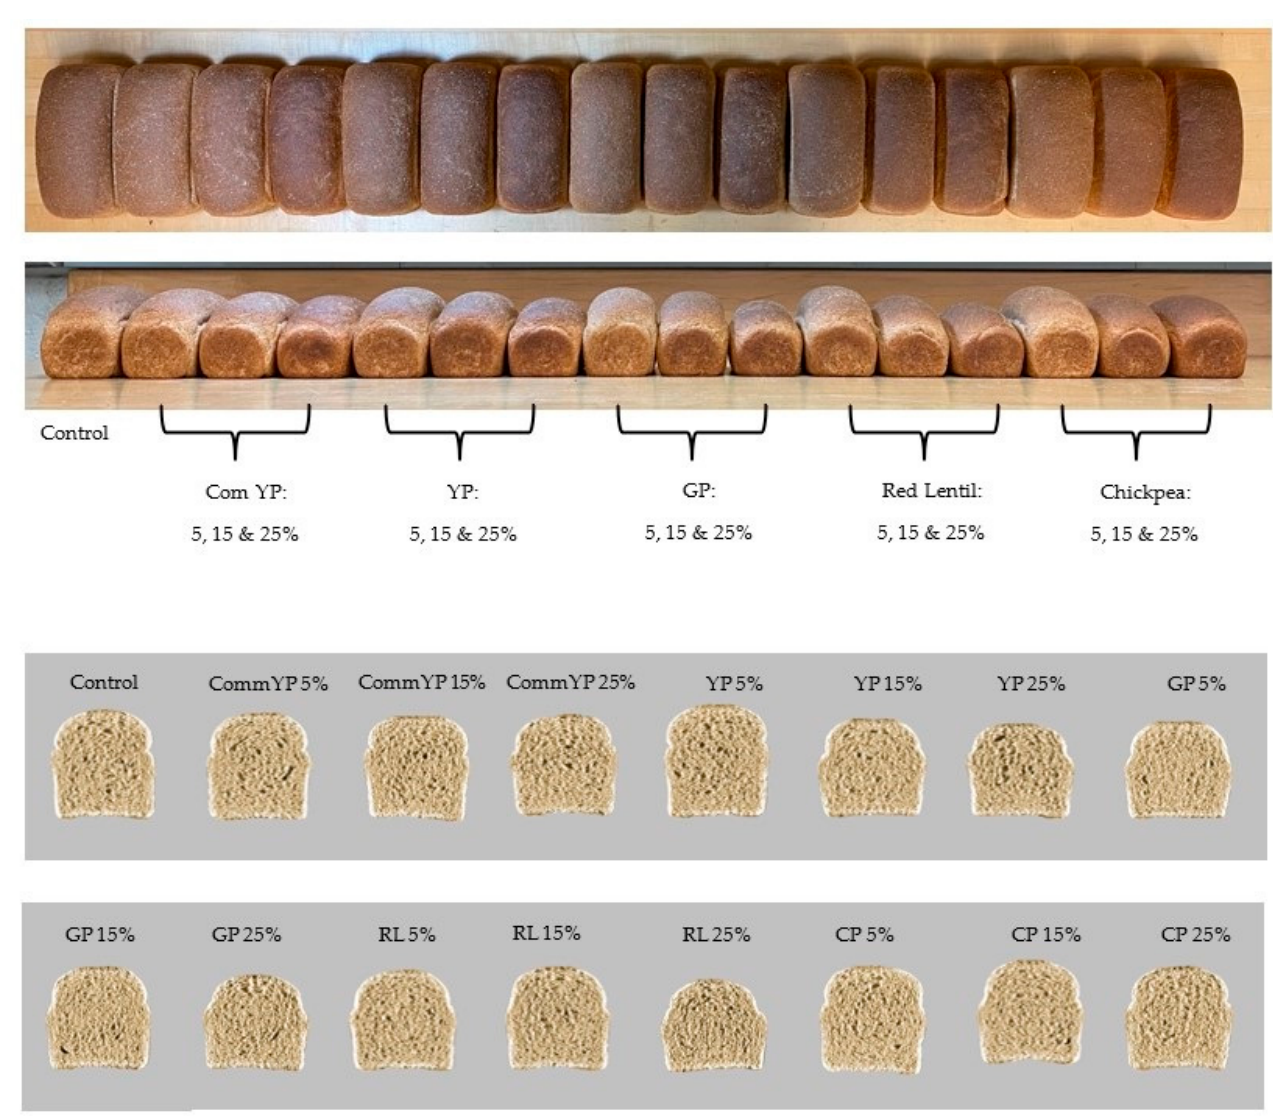
Figure 4. Bread photos and C-cell images. (CommYP, commercial yellow pea; YP, yellow pea; GP, green pea; RL, red lentil; CP, chickpea.).